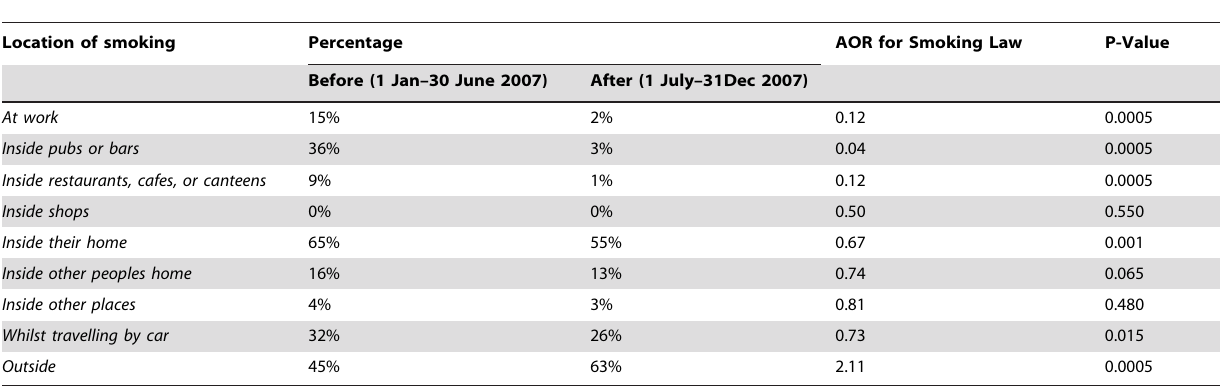
Table 2. Location of smoking before and after the introduction of smoke-free legislation.